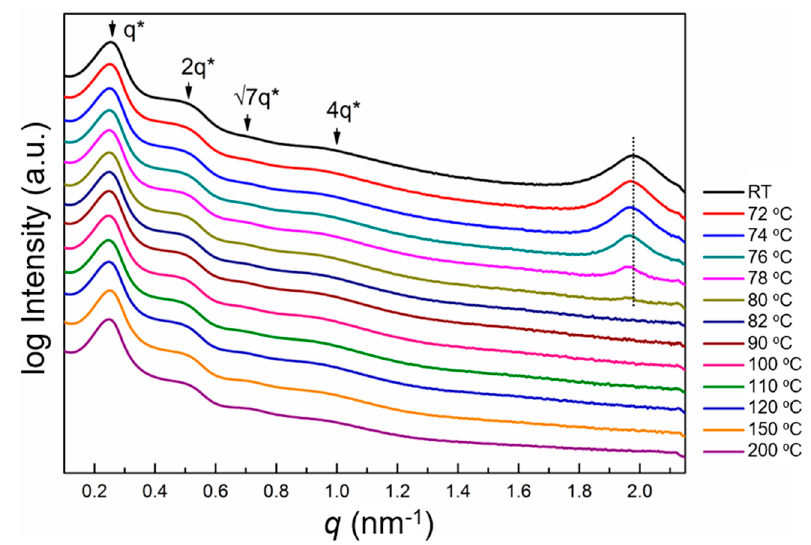
Figure 3. Temperature-dependent SAXS profiles of S74- b -F42.